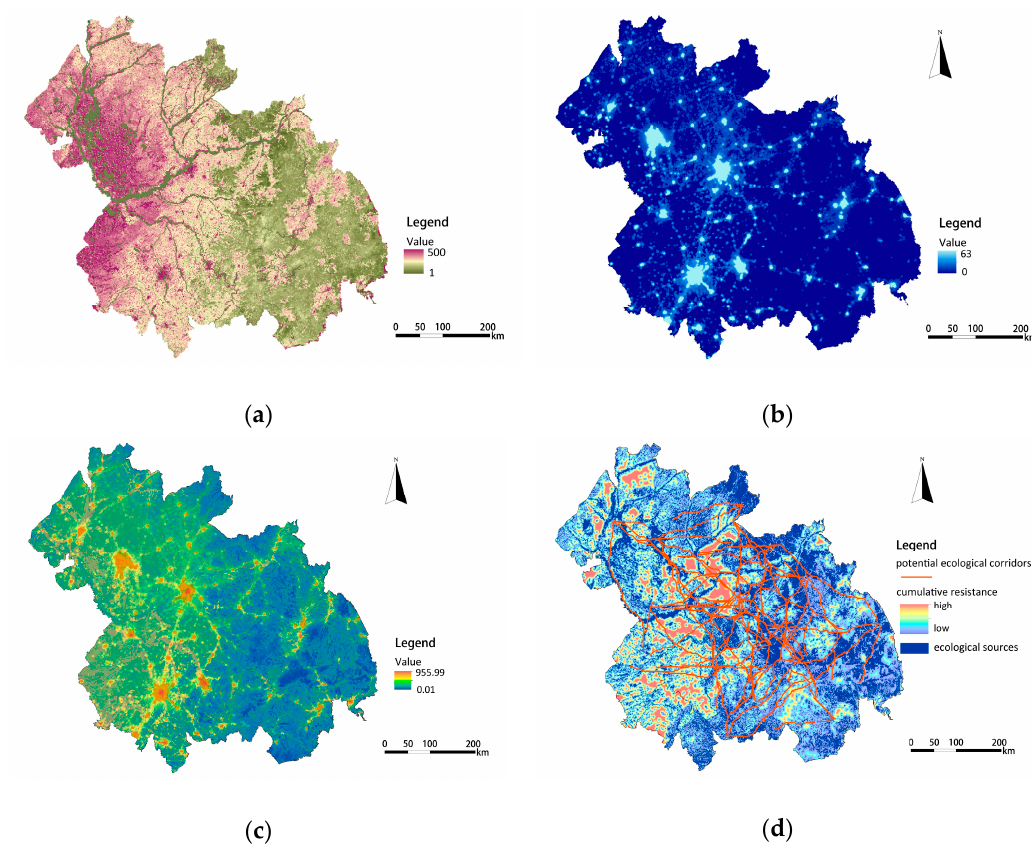
Figure 5. The cost value of the basic resistance surface, nighttime light intensity (TLI), and potential ecological corridors: ( a ) The cost value of the basic resistance surface; ( b ) The spatial distribution of nighttime light intensity (TLI); ( c ) The spatial distribution of the modified resistance surface; ( d ) The spatial distribution of potential ecological corridors.